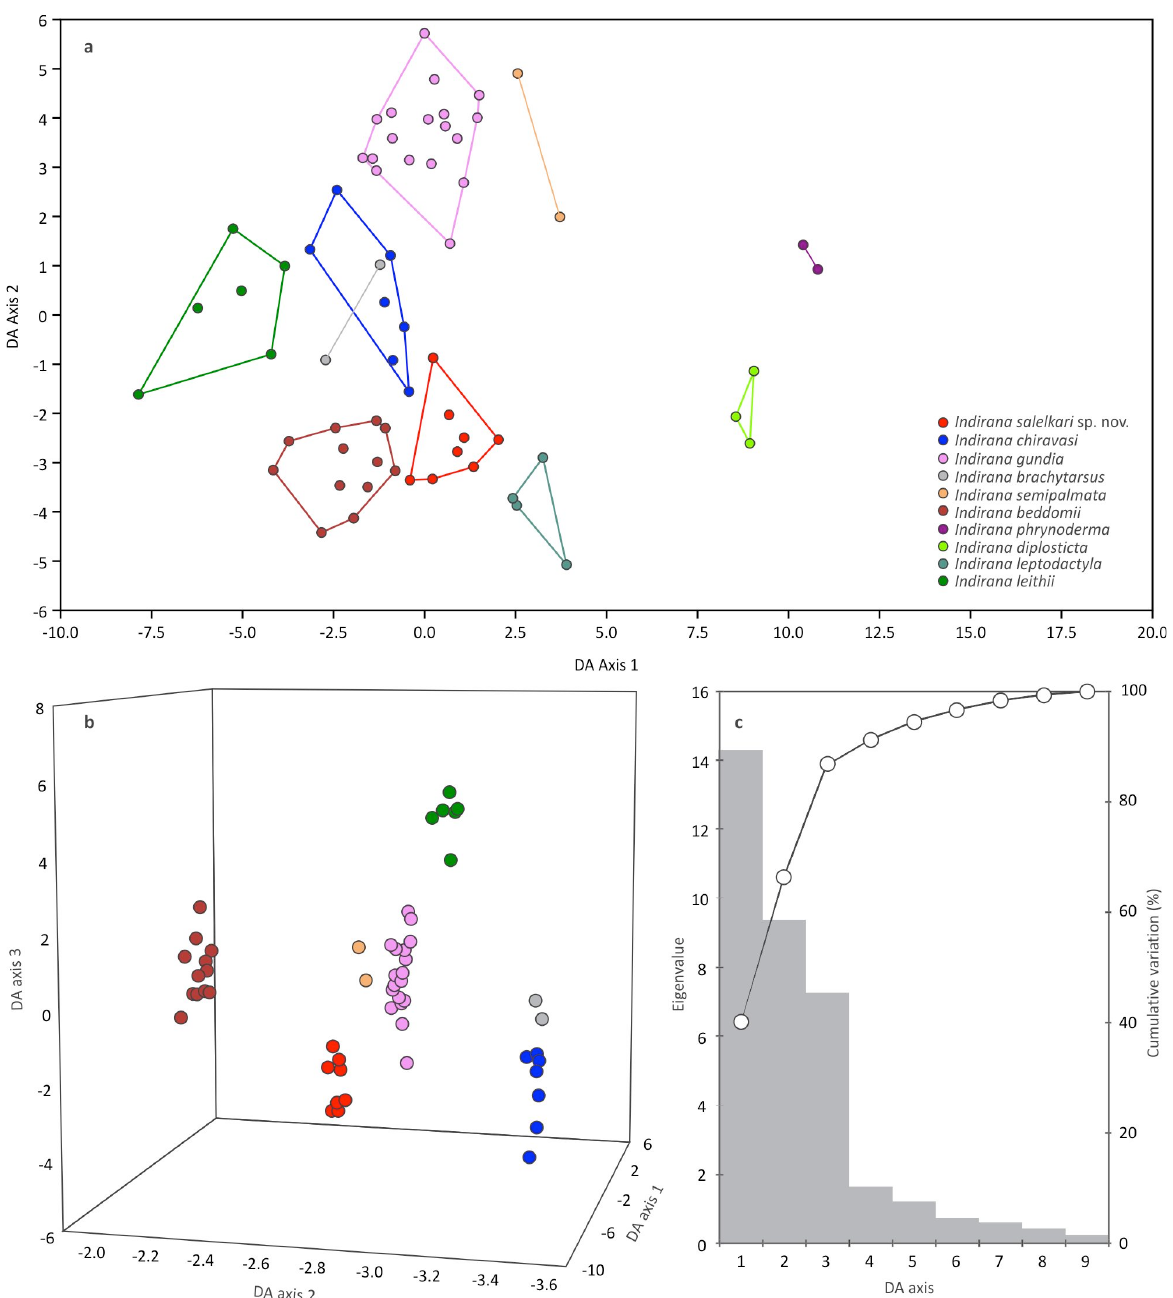
Figure 5. Discriminant analysis of size corrected morphometric data in first two axis for all the species (a) and first three axis for the taxa closely related to Indirana salelkari sp. nov. (b). Scree plot is given in